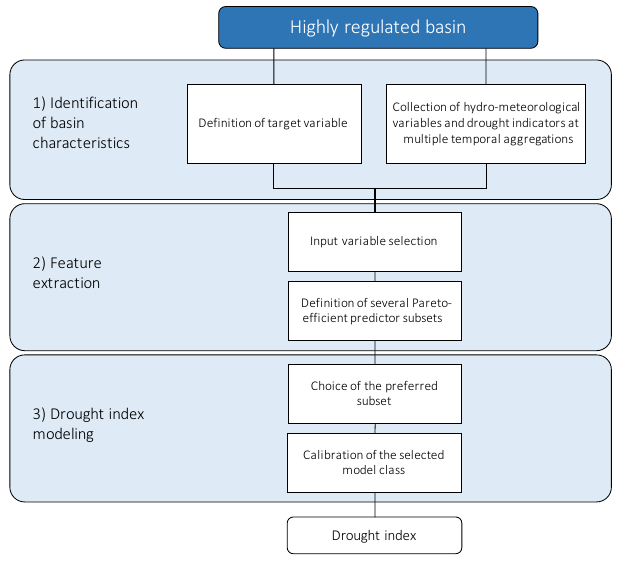
Figure 2. FRamework for Index-based Drought Analysis (FRIDA): 1. Identification of basin characteristics, 2. feature extraction, and 3. drought index